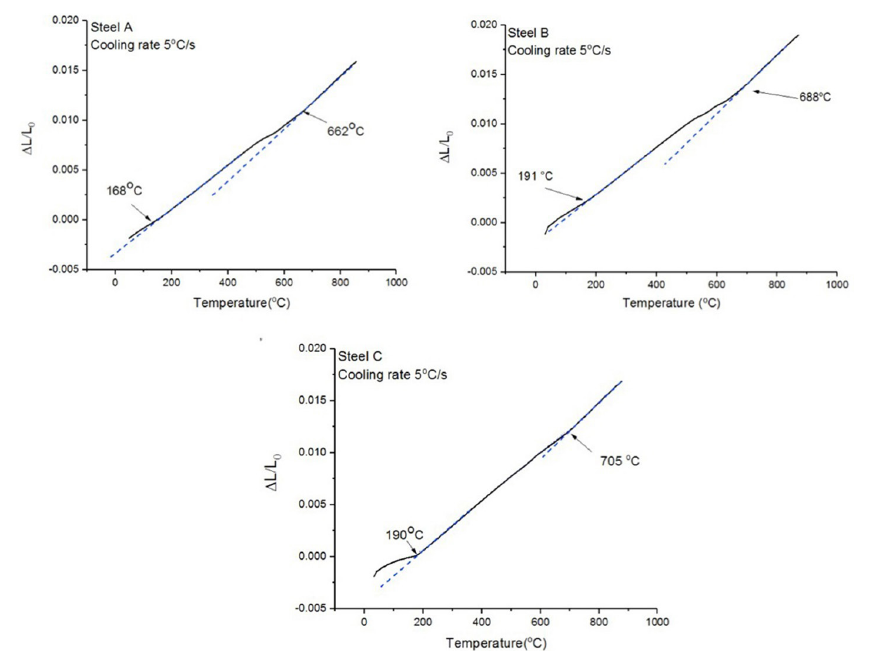
Figure 3. Comparison between the cooling dilatometric curves for steels A, B and C cooled at 5 o C/s.